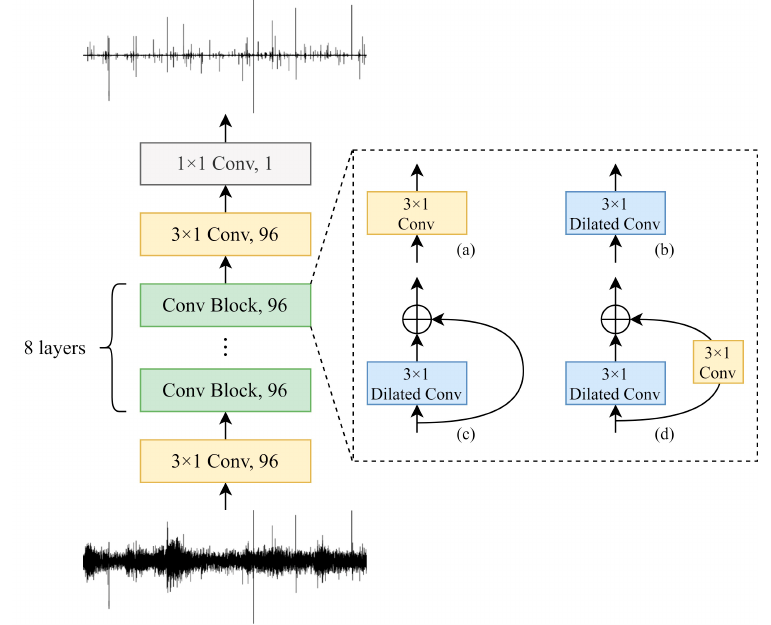
Figure 4. The framework of TDD-Nets with different convolution blocks. ( a ) The standard convolution. ( b ) The dilated convolution. ( c ) The dilated convolution with a shortcut. ( d ) The dilated convolution with a convolutional shortcut.